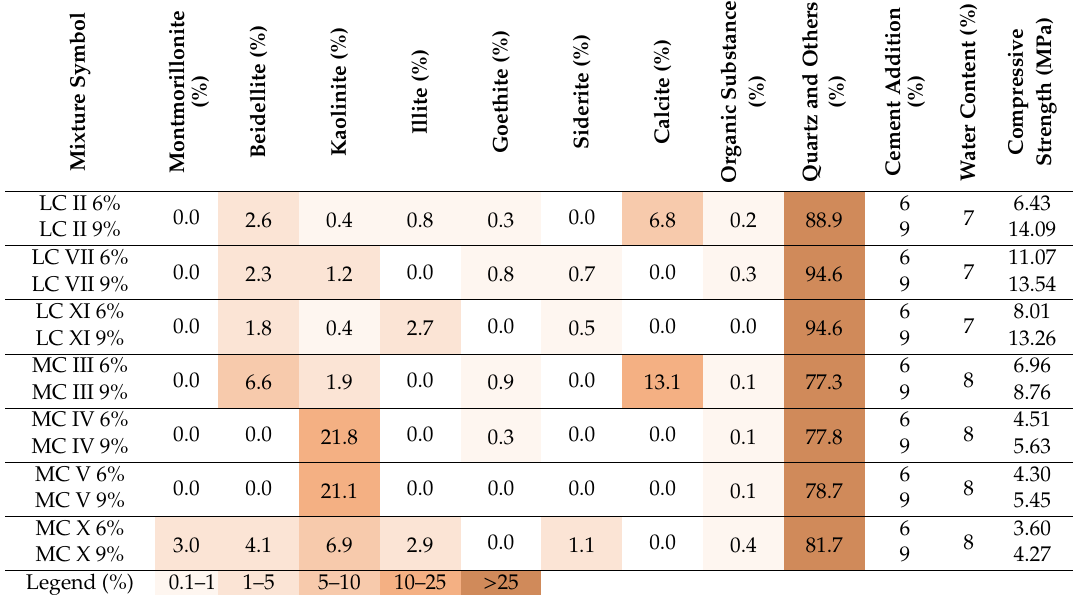
Figure 9. Average moisture content of each CSRE sample series during the compressive strength tests.